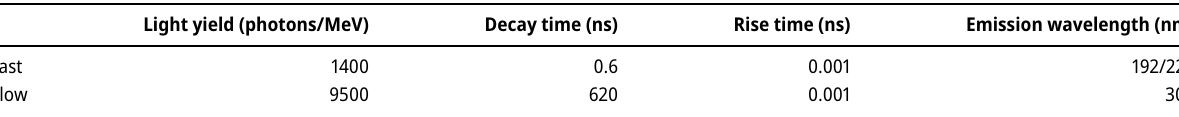
Table 1: Parameters of BaF 2 emission used in the CTR